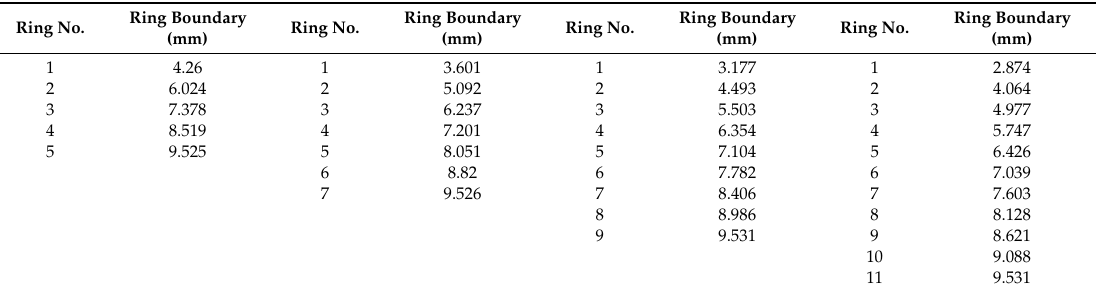
Table 1. Studied four designs of the zone plates with zone number 5, 7, 9 and 11. Ring Boundary Ring Boundary Ring Boundary Ring No. Ring No. Ring No. Ring (mm) (mm) (mm)